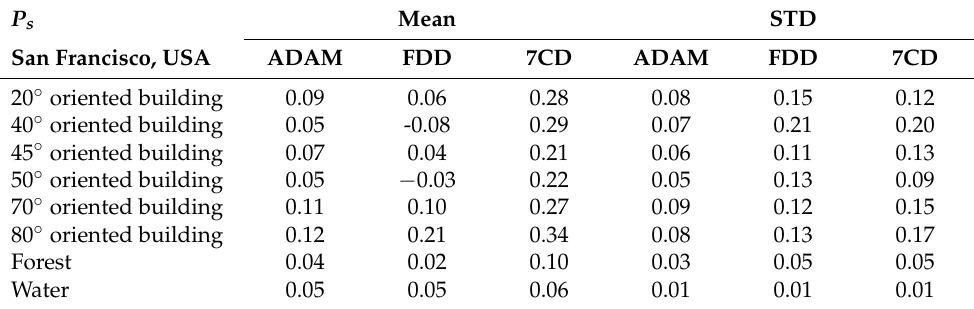
Table 3. The statistical results of surface scattering power P s in 8 types of samples over San Fran- cisco, USA.